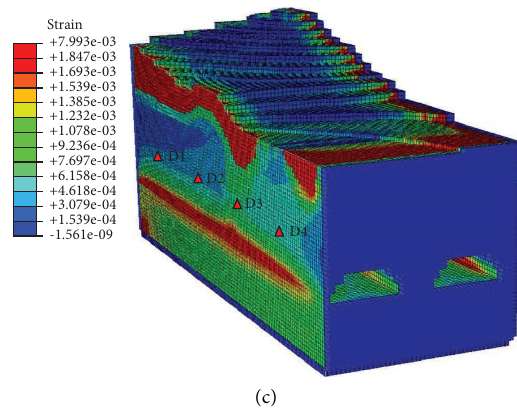
Figure 15: Maximum principal strain under diferent seismic intensities ( t � 5s). (a) VI. (b) VII. (c) VIII.